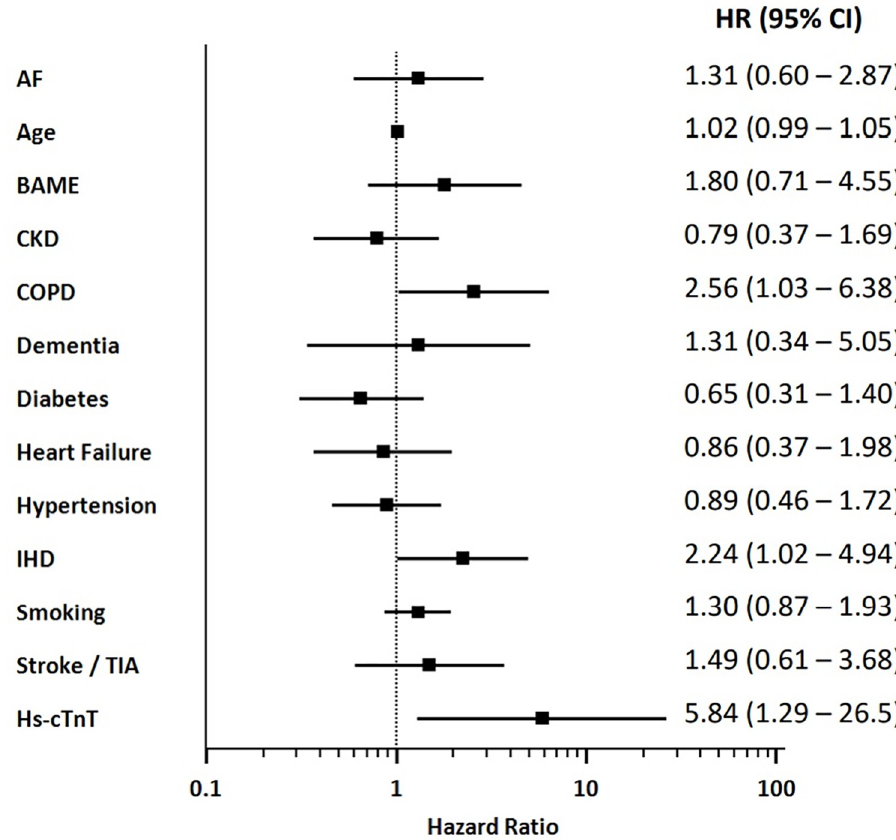
Fig 2. A Forrest plot showing the hazard ratios (HR) of multiple variables for inpatient mortality, as calculated using the multi-variate Cox proportional-hazard regression analysis. HR are displayed with 95% confidence intervals (CI). AF: Atrial fibrillation; BAME: Black, Asian and minority ethnic; CKD: Chronic kidney disease; COPD: Chronic obstructive pulmonary disease; IHD: Ischaemic heart disease; TIA: Transient ischaemic attack; Hs-cTnT: High sensitivity cardiac troponin